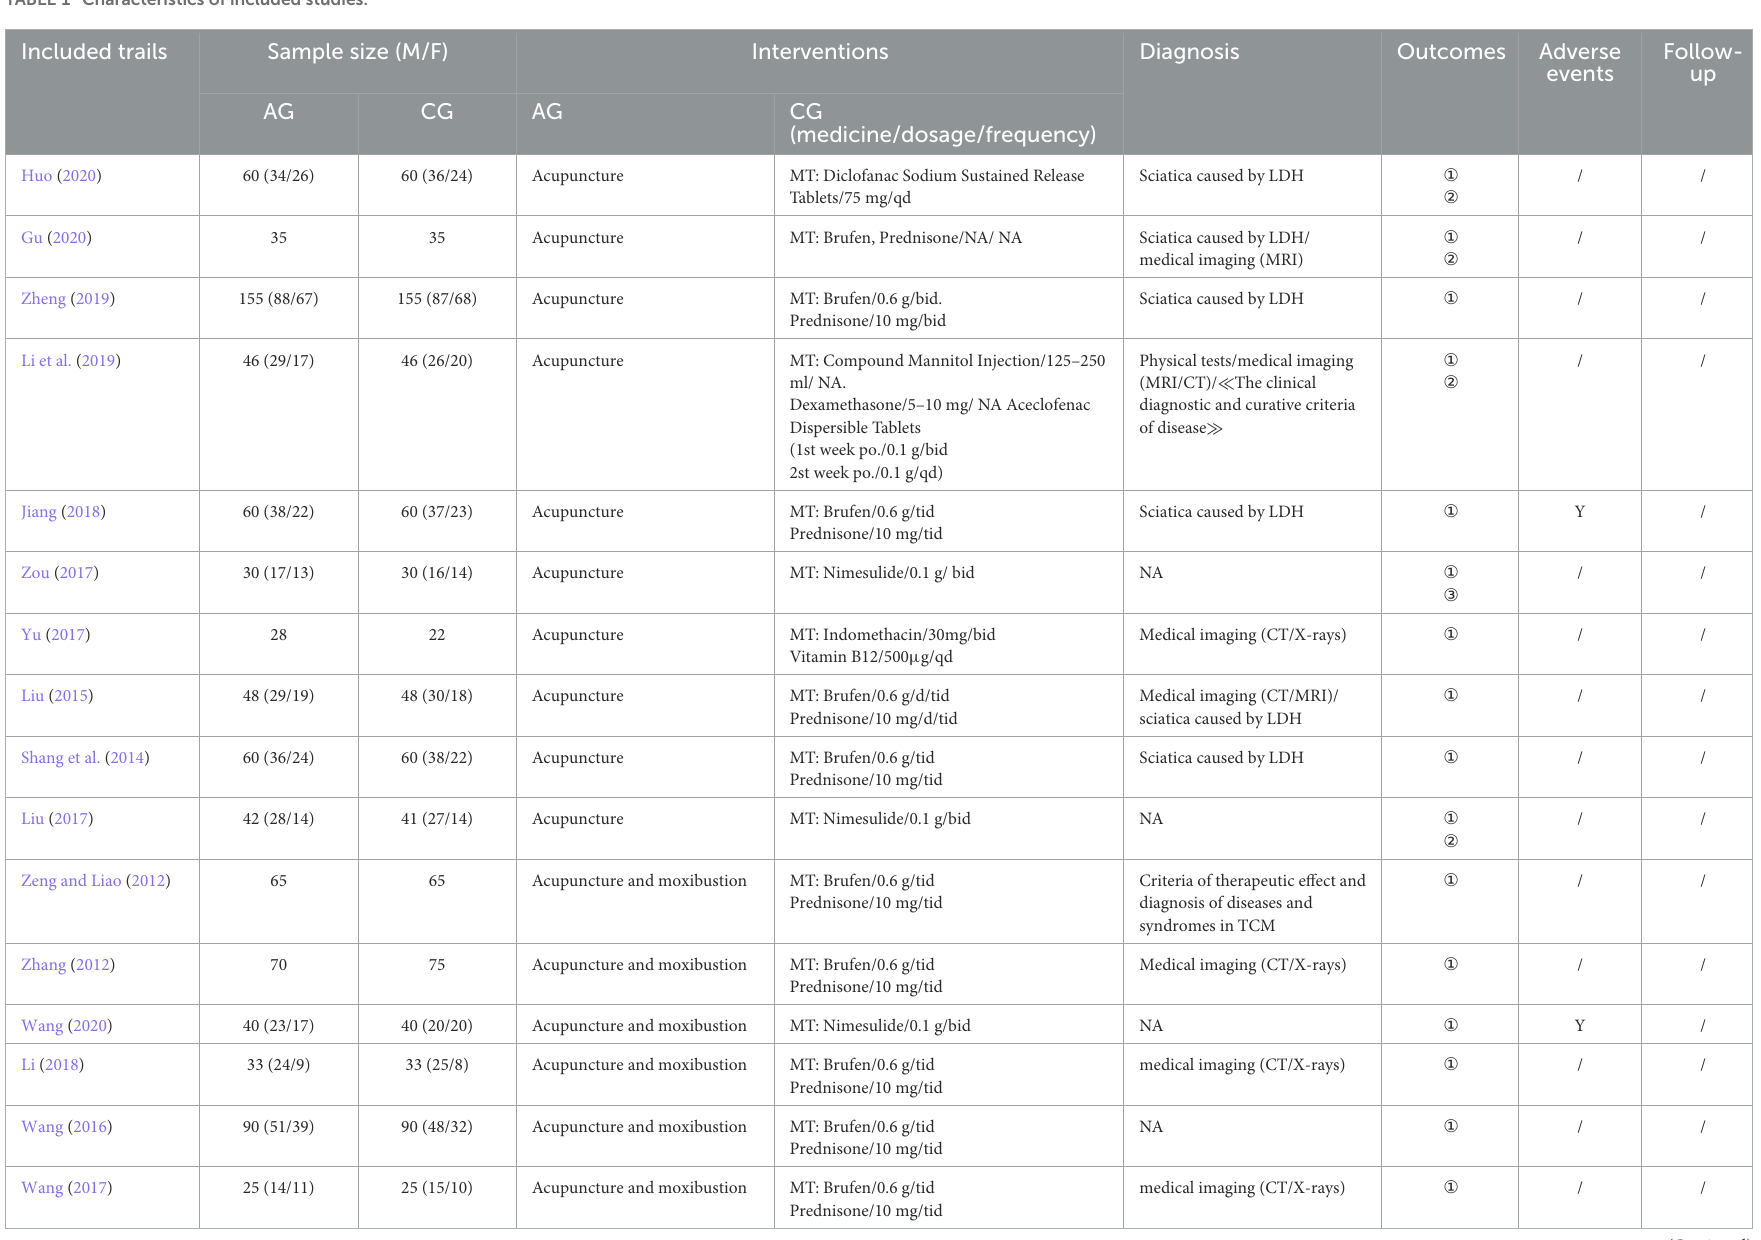
TABLE 1 Characteristics of included